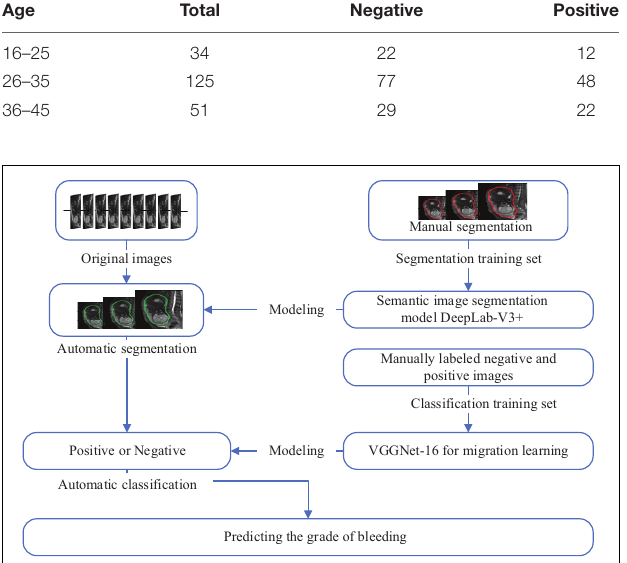
FIGURE 3 | Flow chart of experimental